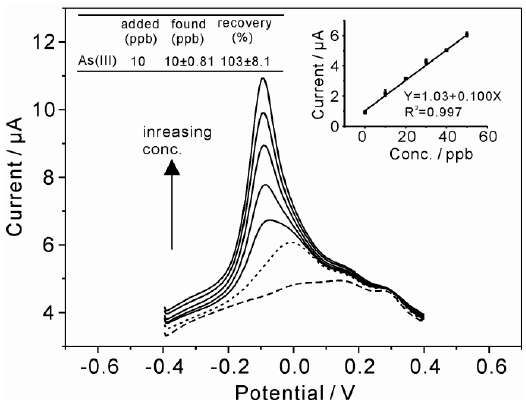
Figure 7. SWASV responses of standard additions of As(II) into a real water sample diluted with 0.1 M NaAc-HAc solution (pH 5.0) in a ratio of 1:9 and the corresponding calibration plot of peak current against As(II) concentrations. The dash dotted line is the baseline in the solution of 0.1 M NaAc-HAc (pH 5.0) containing 1.0 mL of the real sample. The dotted line is the SWASV response toward 10 ppb As(III) in the solution of 0.1 M NaAc-HAc (pH 5.0) containing 1.0 mL of the real sample. The inset table is the recovery calculation. Error bars are the standard deviation for three consecutive measurements. SWASV conditions are identical to those in Figure 4.